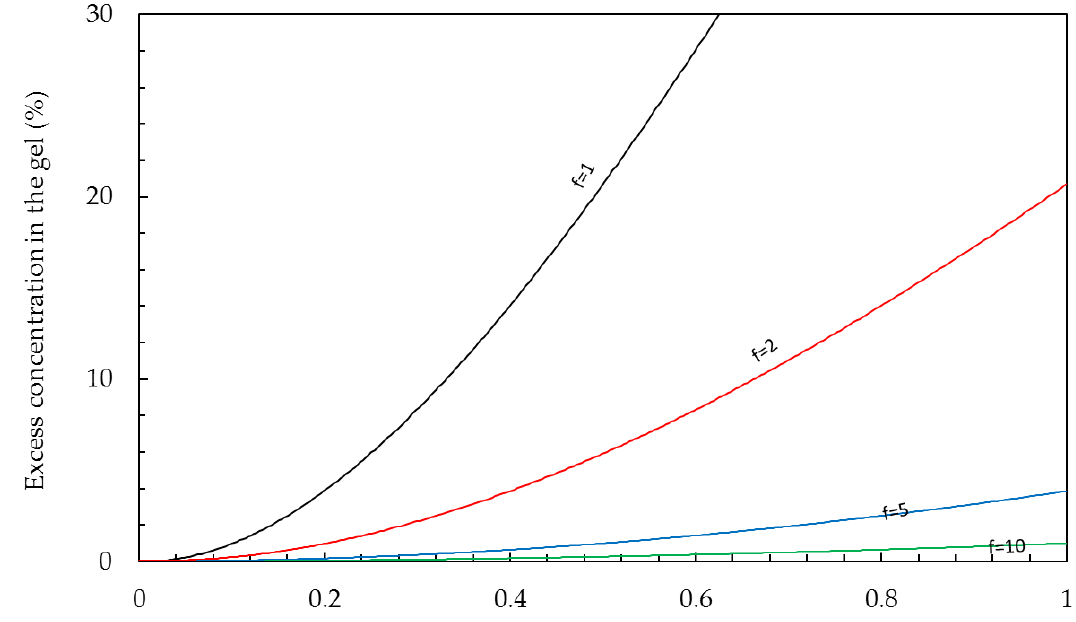
Figure 3. Effect of the bulk concentration and the charge density (f) on the excess